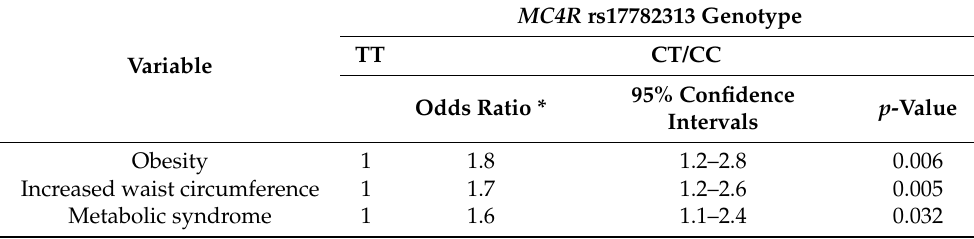
Table 5. Odds ratios for obesity, waist circumference, and metabolic syndrome by MC4R rs17782313 genotypes in adulthood.